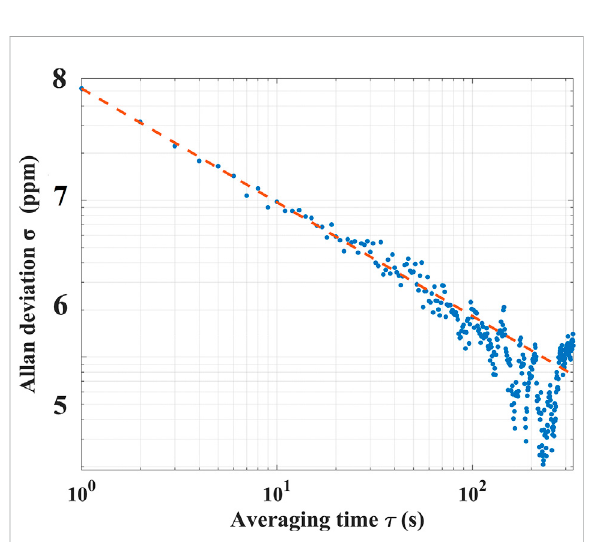
FIGURE 12 Allan variance plotfor time series measurements of pureCO 2 and a slope indicating white behavior of the instrument.